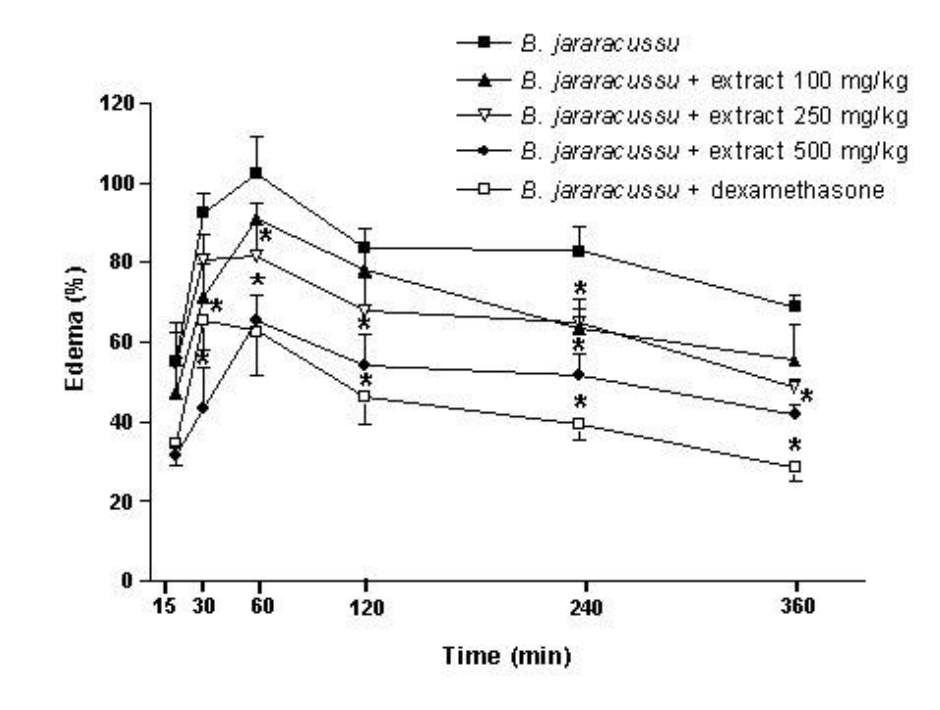
Figure 1. Antiedematogenic effect of the ethanolic extract from the B. portulacoides aerial parts on paw edema induced by B. jararacussu venom. Mice injected with